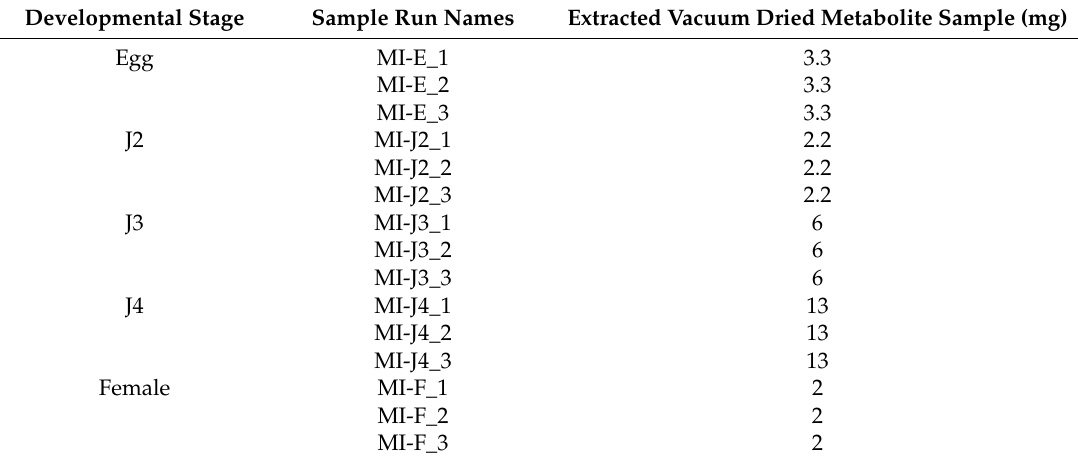
Table 4. Sample details of M. incognita used for metabolite